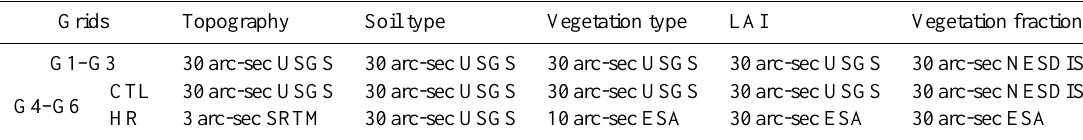
Table 4. Summarized surface database configuration of the one-way nested numerical grids.